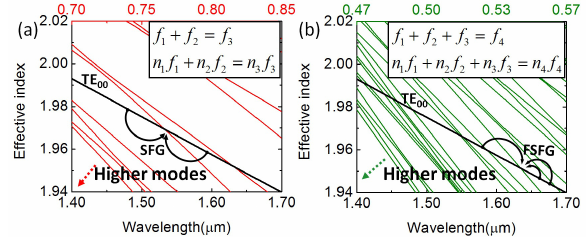
Figure 8: The simulated effective index of the fundamental TE mode near 1550 nm (black line) crosses (a) modes near 775 nm (red lines) and (b) modes near 517 nm (green lines) in the AlN waveguide. The inset equations are phase-matching conditions, and are satisfied at each mode crossing. AlN: aluminum